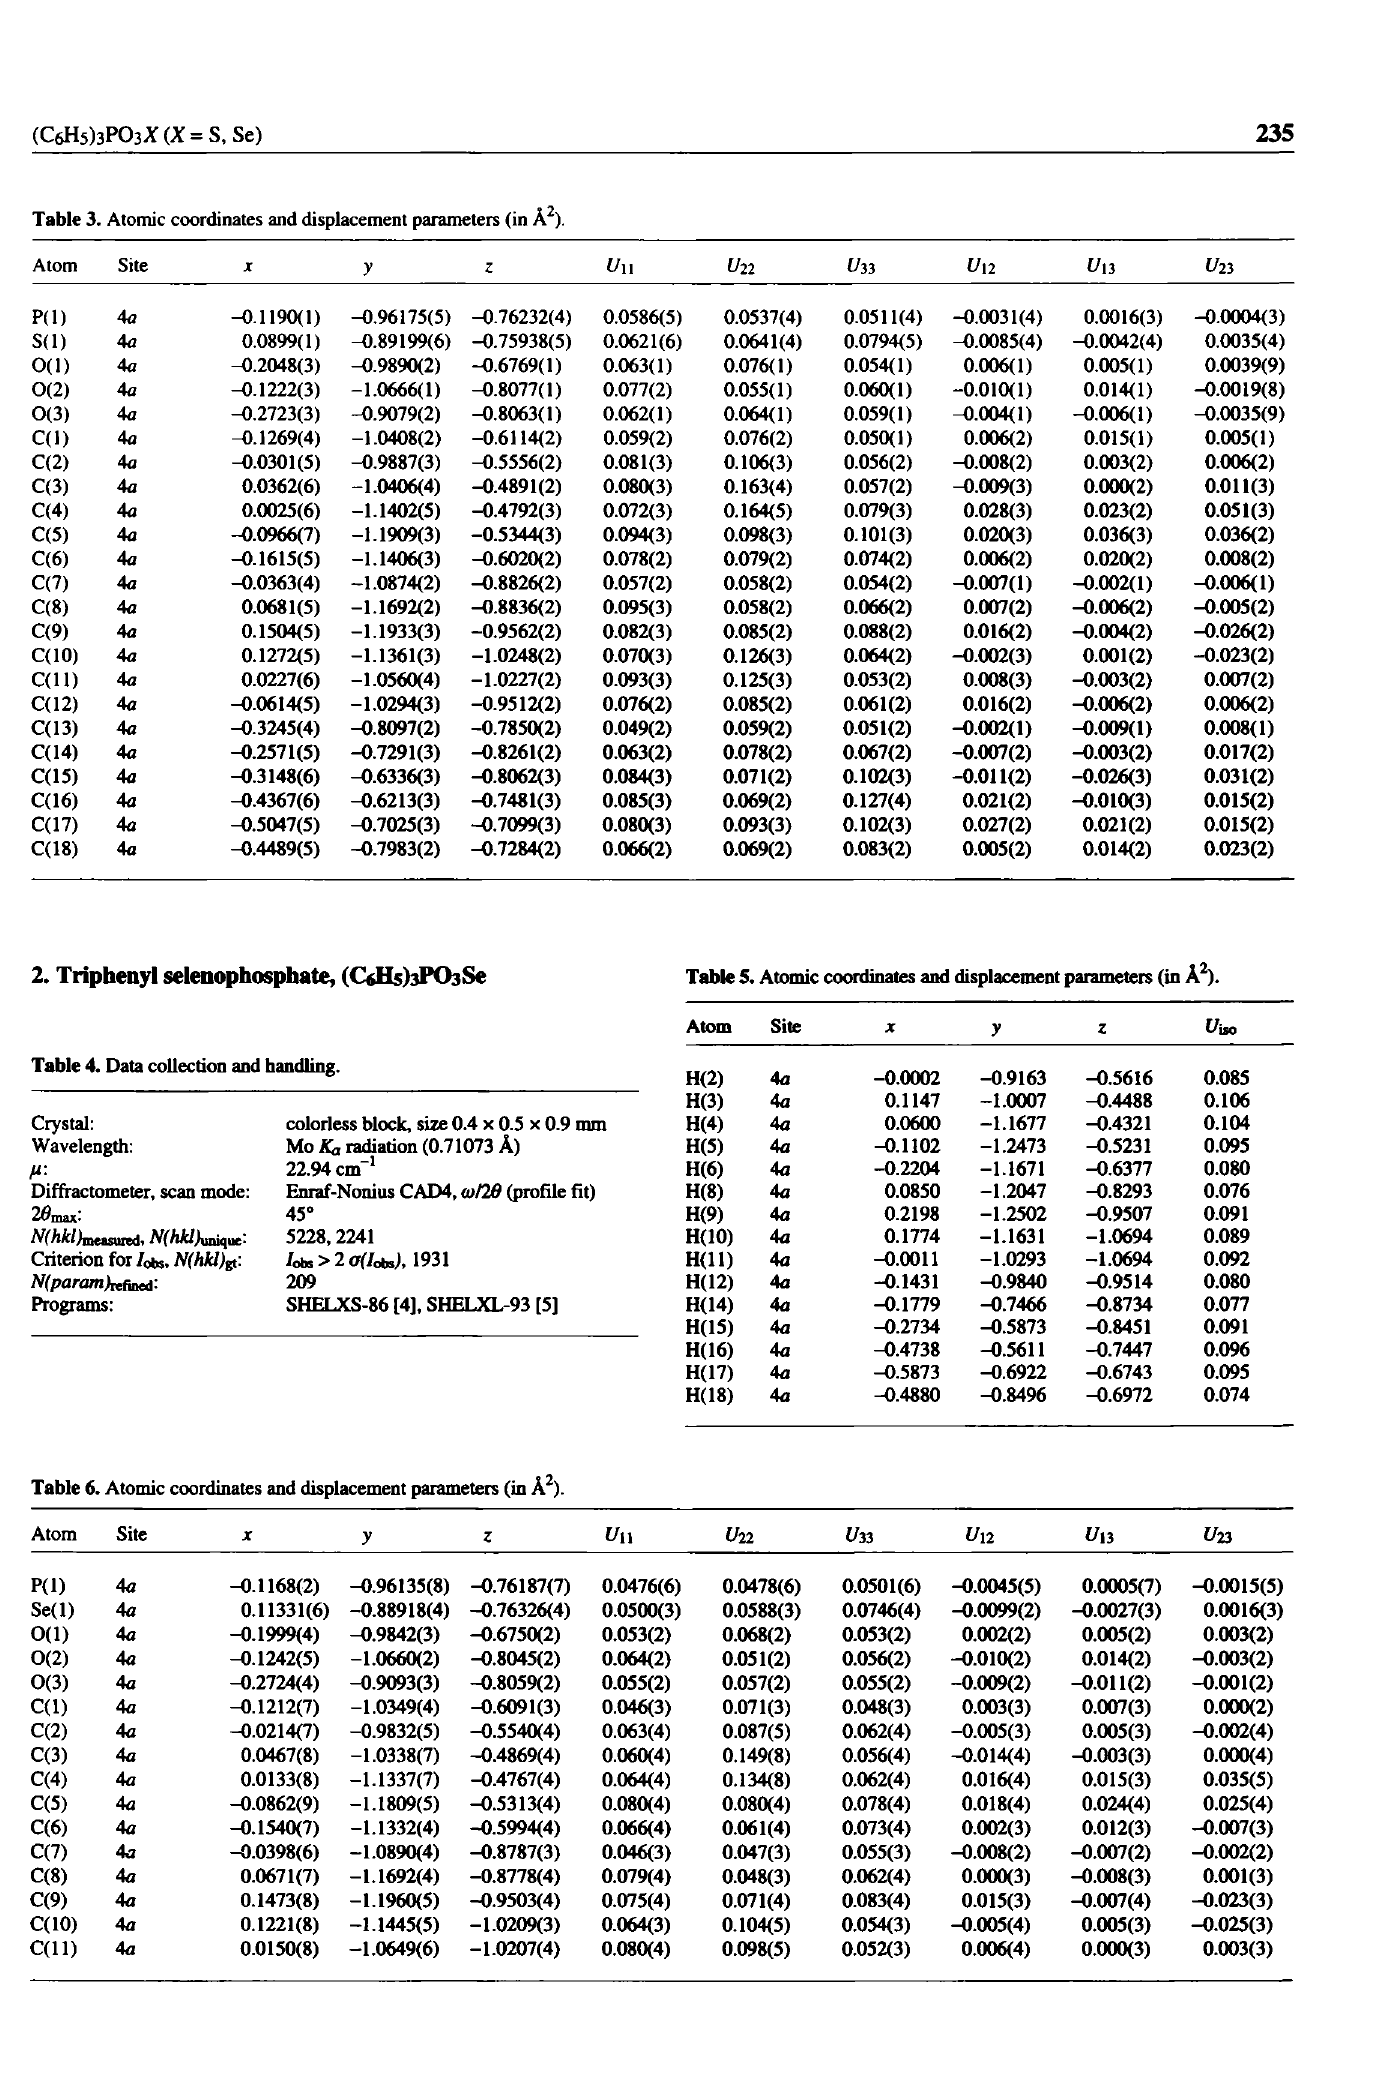
Table 6. Atomic coordinates and displacement parameters (in Ä 2